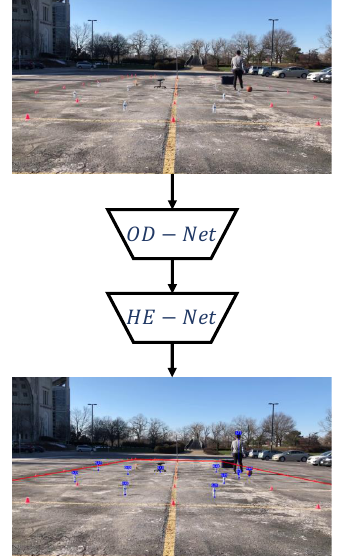
Figure 2. Object detection and height estimation